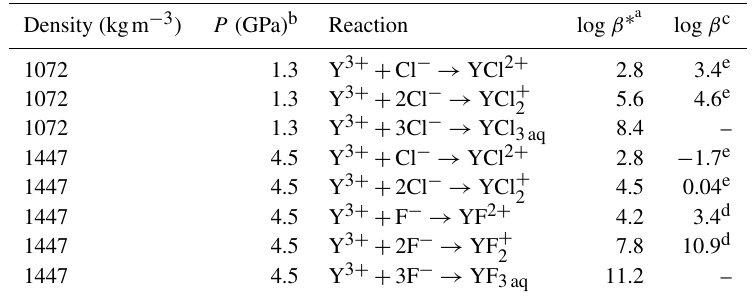
Table 4. List of the logarithmic stability constants log β ∗ derived from ab initio thermodynamic integration in comparison to theoretical predictions based on HKF regression.